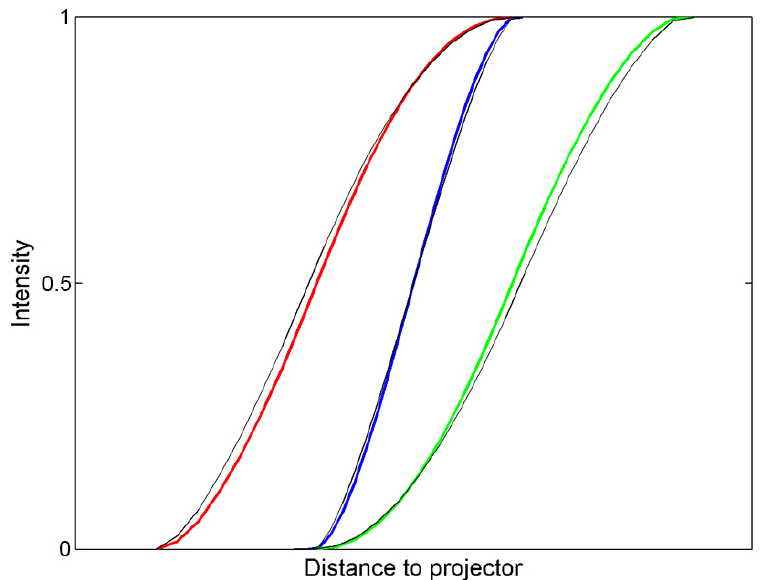
Figure 7. Theoretical shadow illumination profiles for different projector geometries: A 45° pyramidal Peak (red, ψ = 45 ◦ ), a flat ridge (blue, ψ = 0 ◦ ), and a 45° triangular notch (green, ψ = 135 ◦ ). Black lines correspond to the same geometries, but neglecting limb